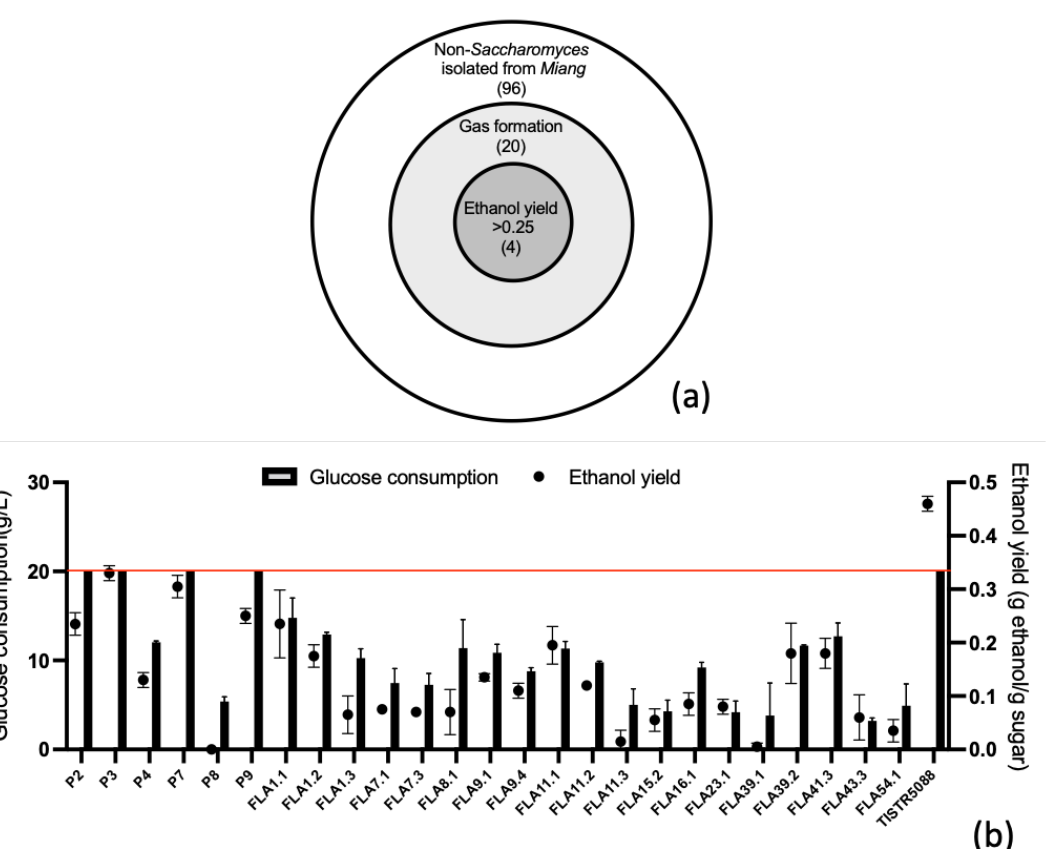
Figure 1. Screening for the ethanol producing yeast isolated from Miang . The graphical ratio of a total screened yeast number, in comparison to the gas-forming and ethanol-producing isolates ( a ). Glucose consumption (g/L) and ethanol yield (g/g sugar consumption) of 24 yeast isolates and S. cerevisiae TISTR 5088 (control) after 3 days of fermentation in YPD medium at 30 °C ( b ). The tolerance to both a low pH condition and bile salts were used to evaluate the probiotic characteristics. The selected isolates showed a high tolerance to pepsin at pH 2.0 after 3 h exposure, with a survival rate of 83.9 to 99.9% (Table 1), whereas the survival rate of bile salt was 66.6 to 91.4%. The highest probiotic potential was in isolate P2, which demonstrated the highest percentage of survival rate, both in bile salt and low pH condi- tions, followed by isolates P3 and P9, respectively. However, the strains are required to survive against the natural barriers of the gastro-intestinal tract, including body temper- ature, a low pH in the stomach and high bile acid concentration at the duodenum in the small intestine [22]. The hydrophobicity of the yeasts was assessed indirectly as the ability to interact with chloroform and the results showed the hydrophobicity index ranged from 31.14 to 52.31%. None of the yeast strains showed β -hemolysis after 5 days incubation (Figure 2a). Several reports have previously described the probiotic properties of non- Saccharomyces yeast species in beverage and food production [10,27 – 30]. This result shows the additional advantage to the potential health benefit using MF-broth. Although, C. rhodanensis were reported to be associated with clinical bovine mastitis [31], but the C. rhodanensis strains investigated in this study are negative for a hemolytic response. In addition to the edible source of the yeast isolate, the negative hemolytic test indicates the safety status for C. rhodanensis used in this study [32].